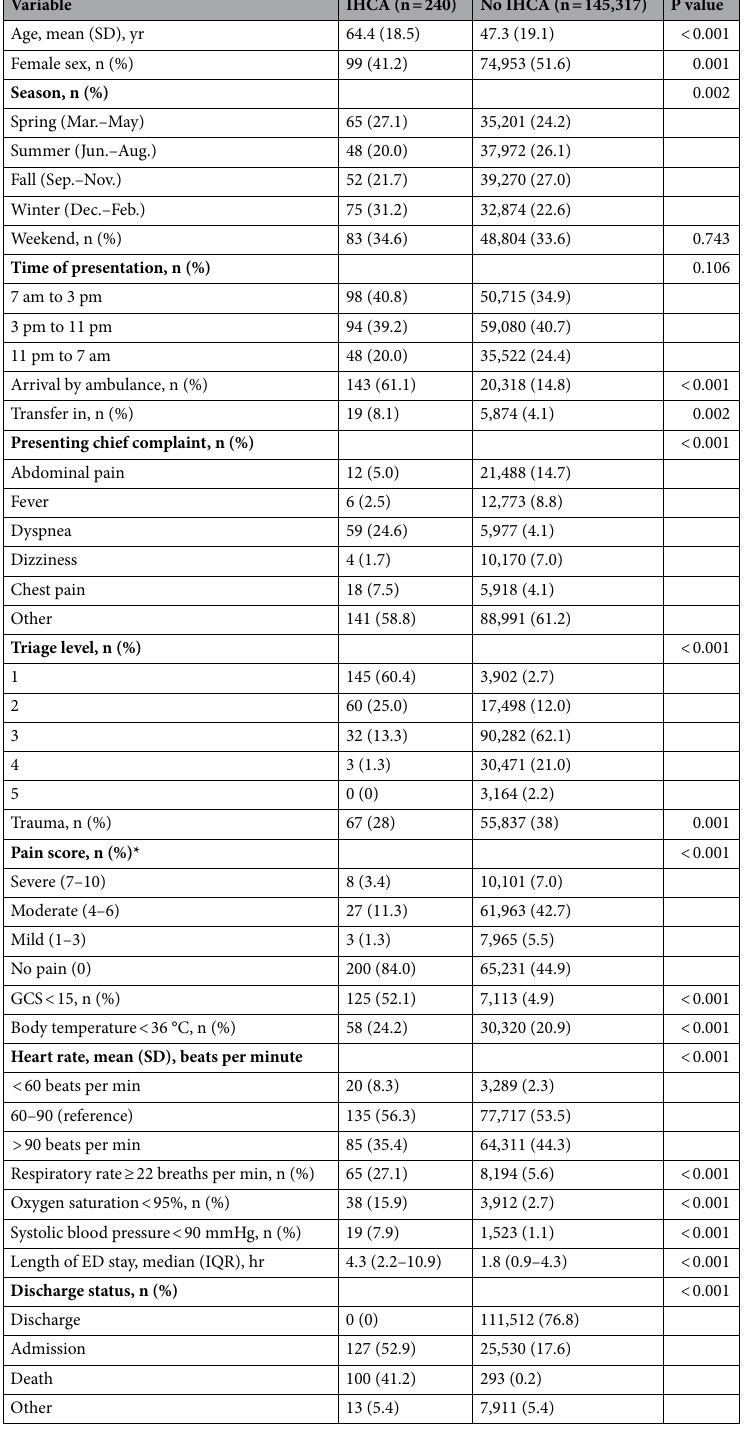
Table 1. Baseline clinical characteristics of emergency department patients by in-hospital cardiac arrest status. IHCA in-hospital cardiac arrest, SD standard deviation, GCS Glasgow coma scale, IQR interquartile range, ED emergency department, ICU intensive care unit. *Available in 145,498